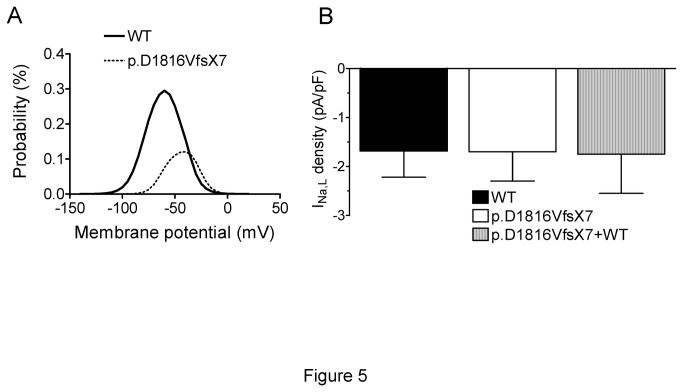
Effects of p.D1816VfsX7 mutation on the window and late Na+ currents.A. Effects of p.D1816VfsX7 mutation on the window current. The probability of being within this window for WT and p.D1816VfsX7 channels is plotted. B. Effects of the mutation on the INaL. Bar graphs show the density of the current generated by WT, p.D1816VfsX7, and p.D1816VfsX7+WT constructs measured at the end of 500-ms pulse to -20 mV from a holding potential of -120 mV. Each bar represents the mean±SEM of >12 experiments.